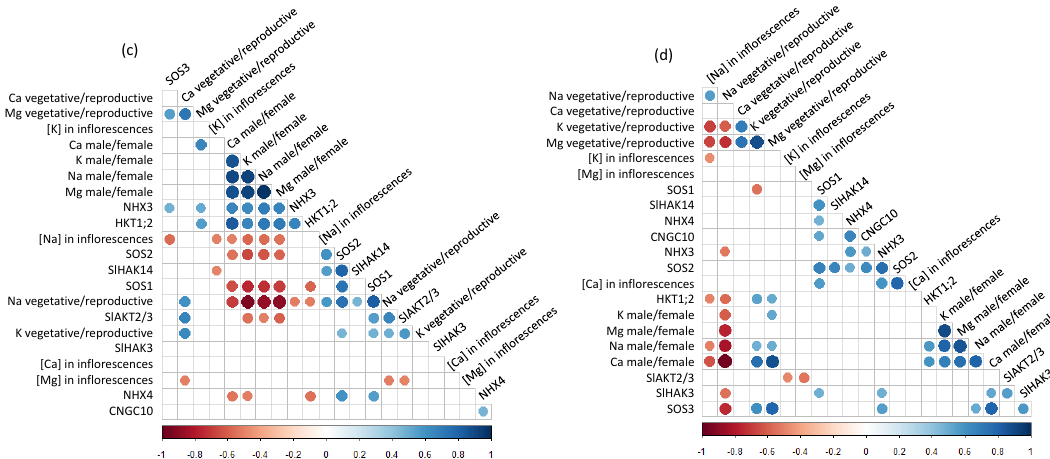
Figure 6. ( a , b ) Correlation graphs of concentrations of elements in inflorescences, ratios of element signals in the vegetative/reproductive organs and male/female organs on flowers and fertility parameters of flowers of Solanum lycopersicum ( a ) and Solanum chilense ( b ). ( c , d ) Correlation graphs of concentrations of elements in inflorescences, ratios of element signals in the vegetative/reproductive organs and male/female organs on flowers and expression of mineral transporters in flowers of S. lycopersicum ( c ) and S. chilense ( d ). Only significant correlations ( p < 0.05) are indicated with circles. Negative correlations are highlighted in red and positive correlations in blue. CNGC10 , Cyclic Nucleotide Gated Channel 10; HKT1;2 , class I — High affinity K + transporter 2; L petals, sepals, style + ovary: length of, respectively, petals, sepals, and the sum of style and the ovary; NHX3 , 4 , vacuolar Na + /H + antiporter 3, 4; N pollen per stamen, seeds per fruit: number of, respectively, pollen grains per stamen and seeds per fruit; SlAKT2/3 , inward-rectifying K + channel; SlHAK3 , 14 , High Affinity K + transporter 3,14; SOS1 , 2 , 3 , Salt Overly Sensitive 1, 2, 3.